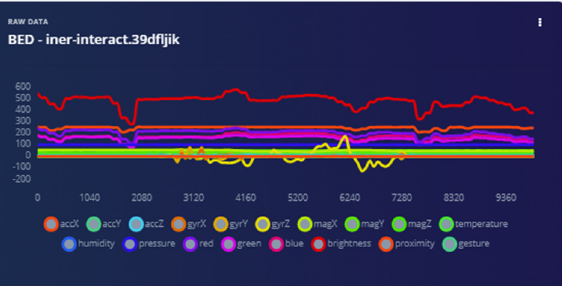
Figure 17. Multiple sensors produce rich data for the ML algorithm to learn and build unique associations within the synchronous time frame (i.e., in temporal sync).